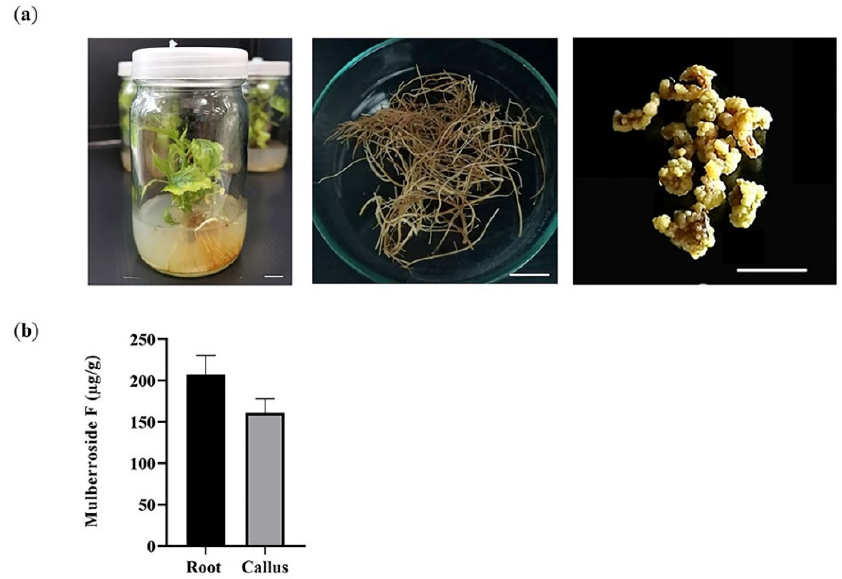
Figure 2. Quantification of mulberroside F in mulberry cultured in vitro. ( a ) Plant material used in this study. 6-week-old mulberry (left), root tissue (middle), and callus (right); ( b ) HPLC analysis of mulberroside F. Error bars were from 3–5 replicates. Scale bar: 1 cm.